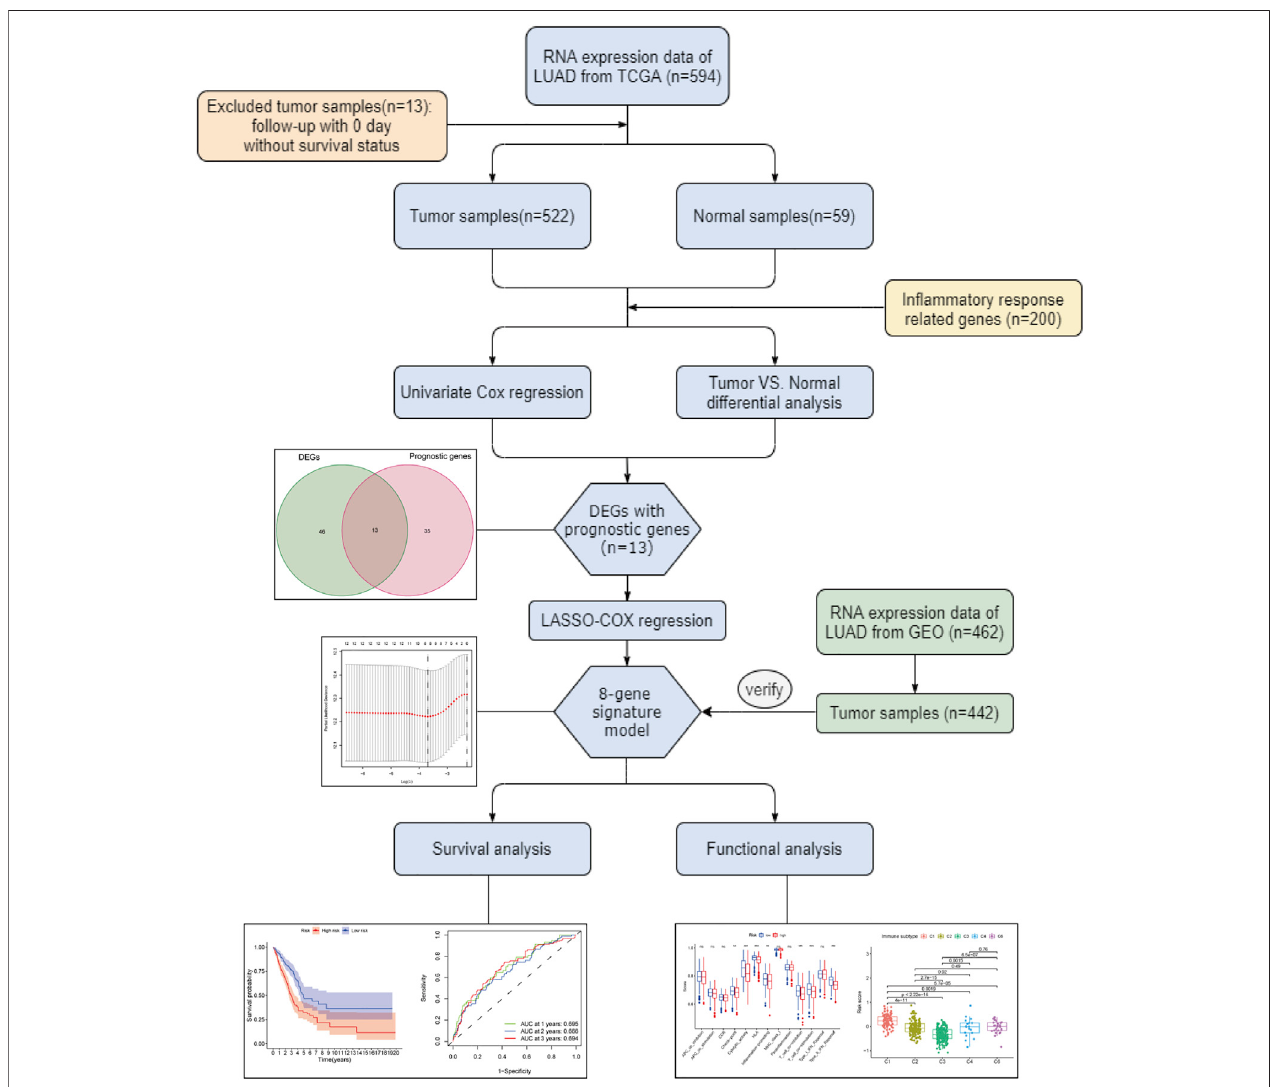
FIGURE 1 | Flow chart of the whole